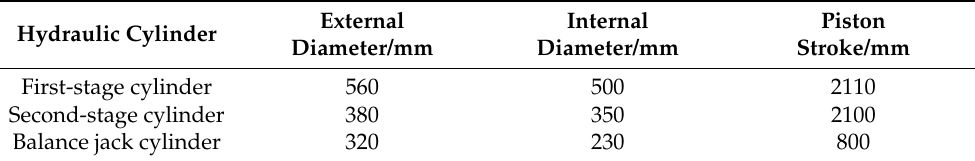
Figure 3. Hydraulic system model: (a) hydraulic operated check valve; (b) stand column; (c) reversing valve; (d) oil tank and pump station; (e) relief valve. Table 4. Dimension parameters of the hydraulic cylinder.